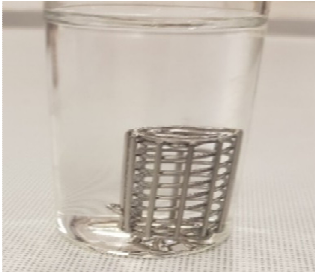
Figure 2. A custom-made sinker used in the release study to avoid the floating of the fibers and the oral dispersible film (ODF).